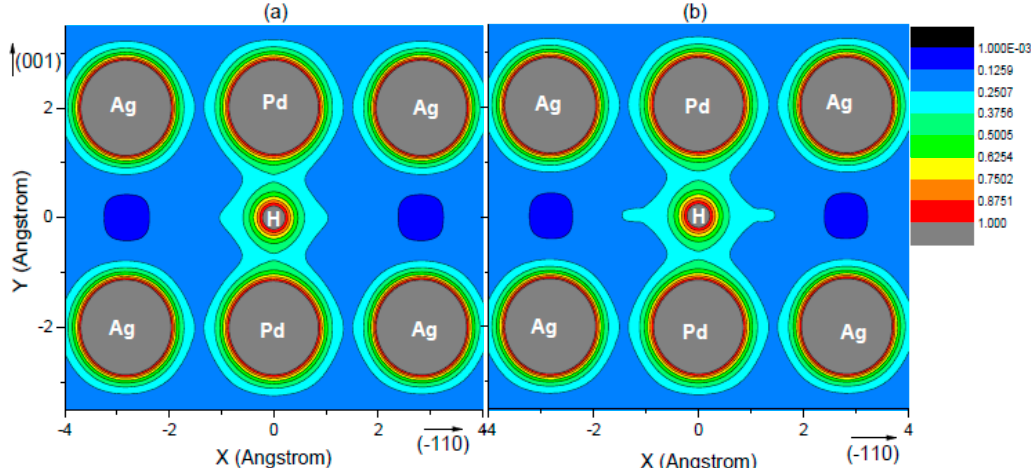
Figure 6. Charge density plots of ( a ) Pd 23 Ag 9 and ( b ) Pd 25 Ag 7 with hydrogen atom at the O1 site; the charge density is expressed as e/Å 3 .